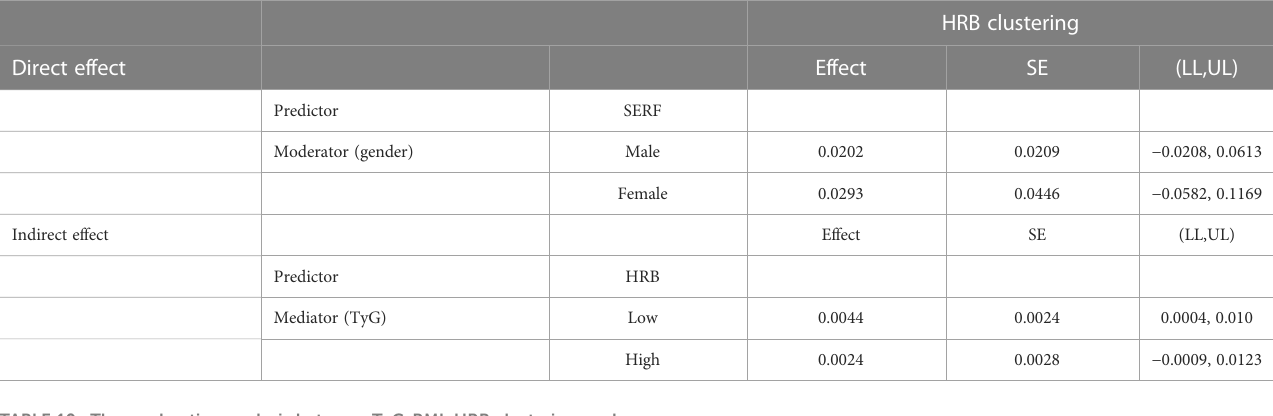
TABLE 10 The moderation analysis between TyG-BMI, HRB clustering, and age.